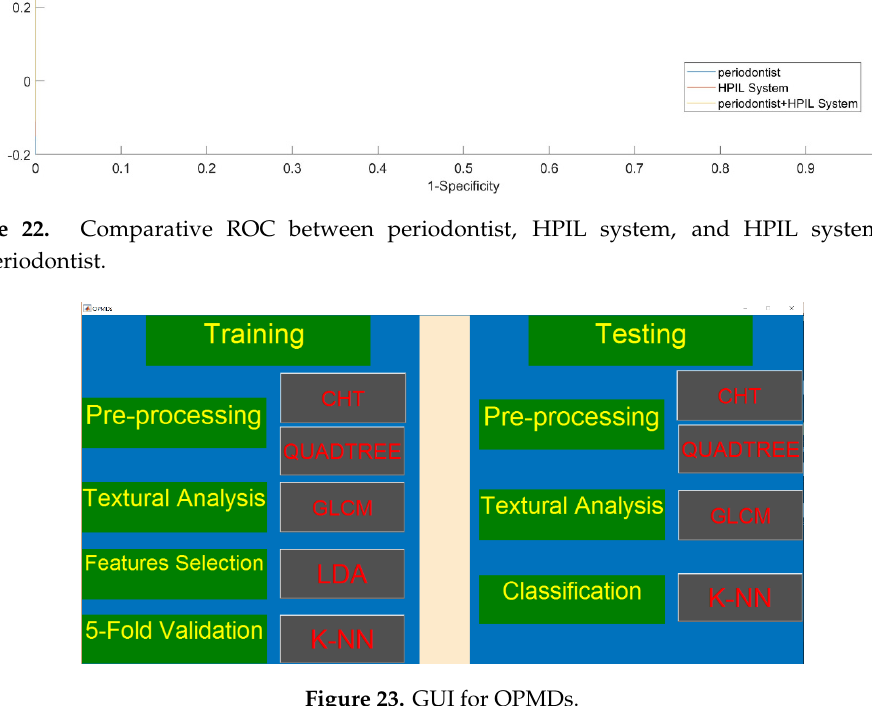
Figure 22. Comparative ROC between periodontist, HPIL system, and HPIL system with the periodontist .